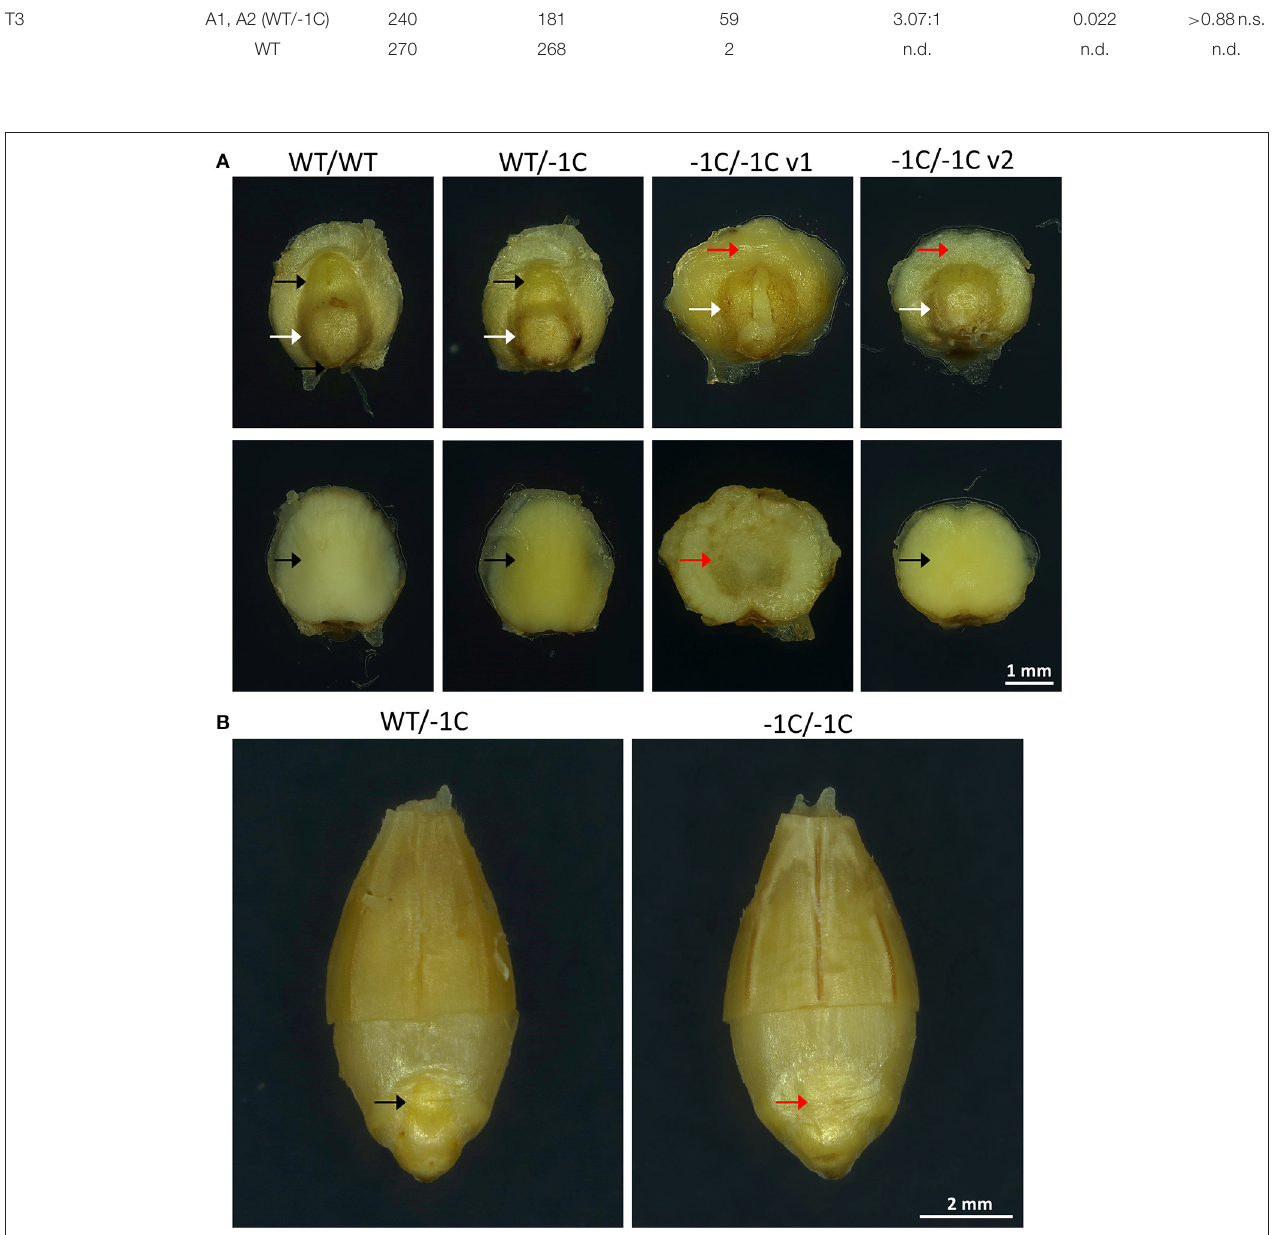
FIGURE 8 | Representative embryos and grains of heterozygous mutants in the HvMPK6 gene (WT/ − 1C). T3-generation mature grains of heterozygous transgenic plants and mature grains of WT non-transgenic control plants were imbibed in Milli-Q water at 21 ◦ C in darkness for 18h before embryo extirpation or husk removal and imaging. (A) A non-transgenic WT (WT/WT) embryo, a heterozygous mutant (WT/ − 1C) embryo, and representatives of two types of homozygous knockout mutant embryos ( − 1C/ − 1C v1 and − 1C/ − 1C v2). The upper line of images—an adaxial site of the extirpated embryos. The white arrow indicates the root part of the embryonic axis and the black arrow indicates the shoot (upper) part of the axis. The red arrow indicates the missing shoot part of the axis. The lower line of images—an abaxial site of the extirpated embryos. The black arrow indicates the normal shape and the red arrow indicates the hollow shape of the abaxial embryo site. (B) A heterozygous mutant (WT/ − 1C) grain and a homozygous knockout mutant ( − 1C/ − 1C) grain. From each grain approximately half of the husk was removed to allow for the embryo morphology evaluation. The black arrow indicates the shoot part of the embryonic axis, and the red arrow indicates the missing shoot part of the axis.